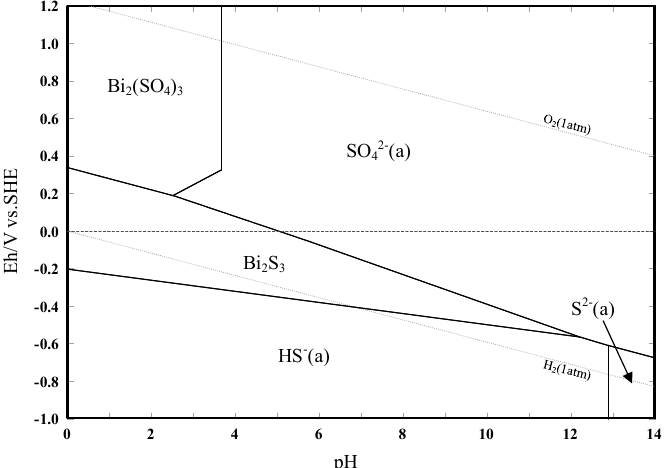
Figure 11. The Eh–pH diagram for the Bi ‐ S ‐ H 2 O system. Conditions: 2 × 10 − 4 M bismuth, 3 × 10 − 4 M sulfur, 298.15 K, 1 atm.